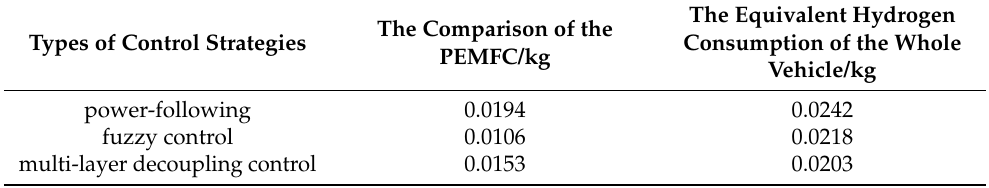
Table 4. Hydrogen consumption results for the three control